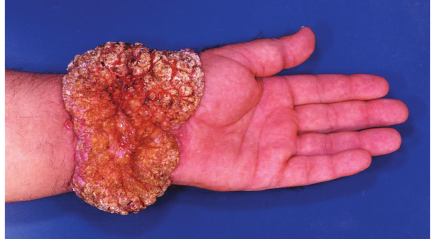
Figure 1: Tumoral and cauliflower-like lesion on the left wrist.